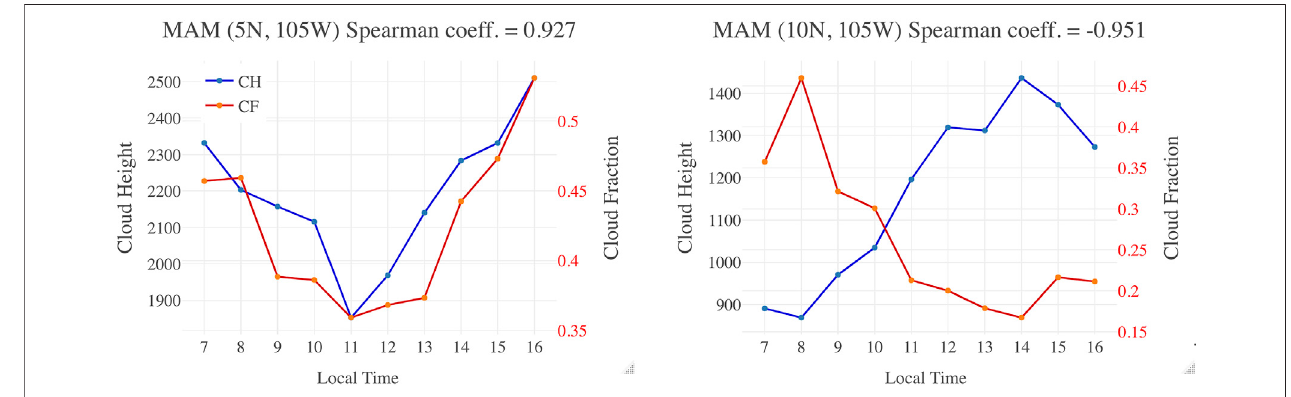
FIGURE7| Spearmancorrelationcoef fi cientbetweencloudfractionandcloudeffectiveheightforlowcloudsusingEPIC.Bluecolorsindicateanegativecorrelation while red colors a positive one.